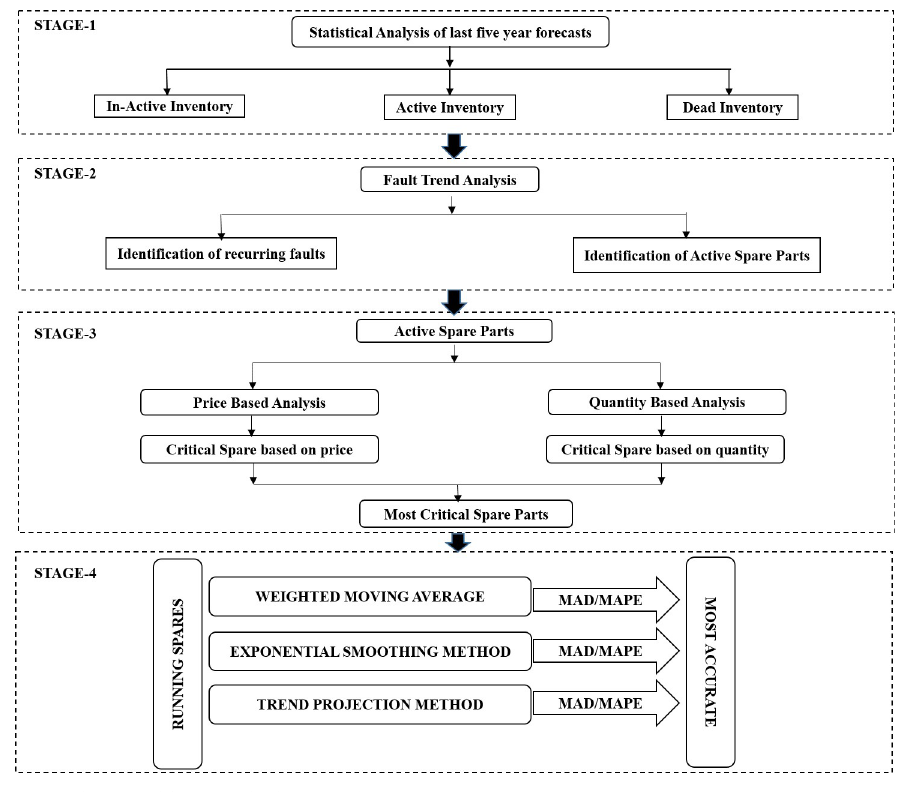
Fig 1. Theoretical framework of proposed DSS.